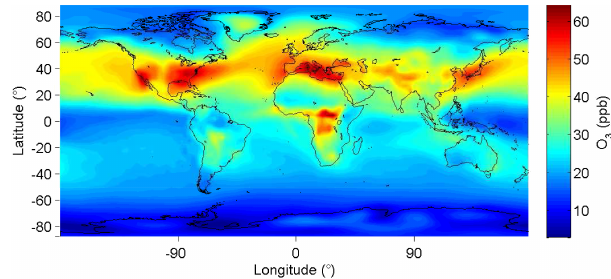
Figure 4. As for Fig. 3a, but for the surface instead of 500hPa.